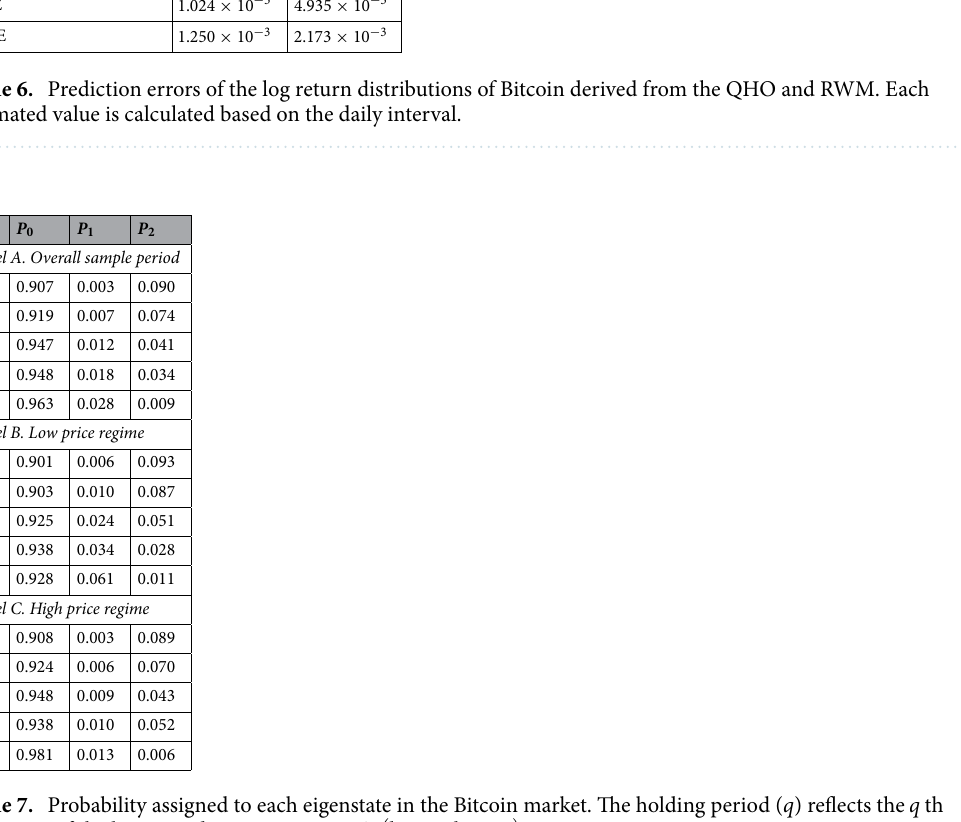
. 252.5 / q ln p t ln p t q = − − (cid:31) (cid:30)